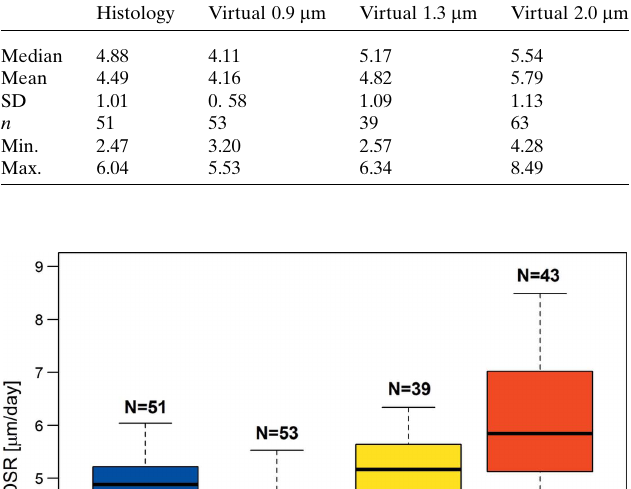
Table 2 DSR statistics for the dataset; SD = standard deviation.